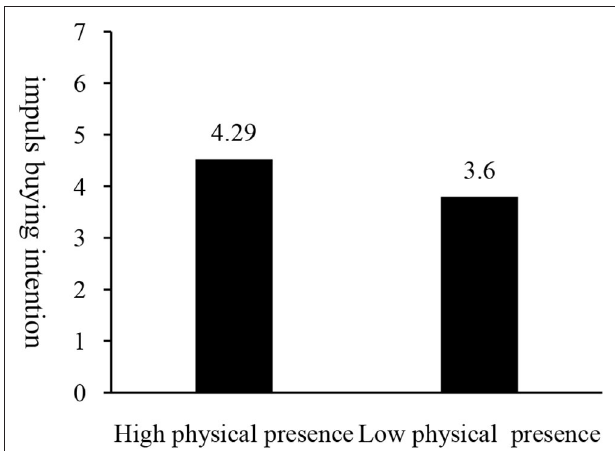
FIGURE 10 | Impact of physical presence on impulse purchase